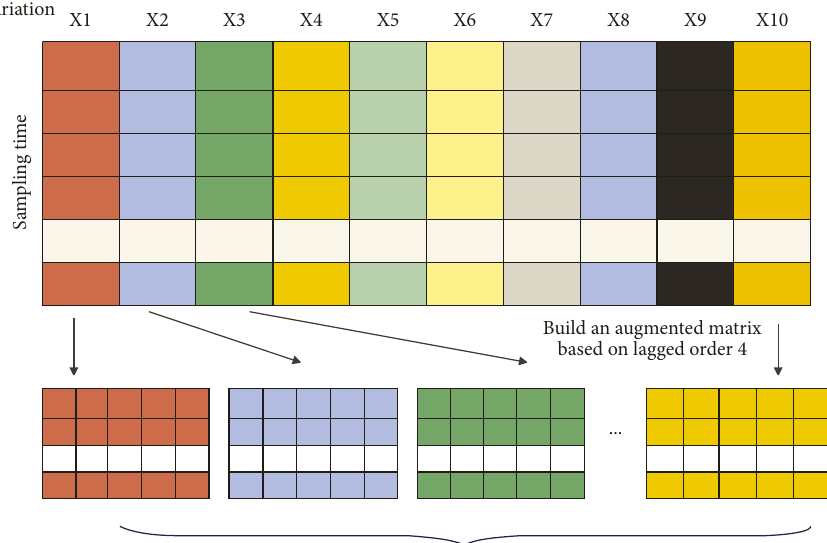
Figure 6: Schematic diagram of constructing augmented matrix with different variables.